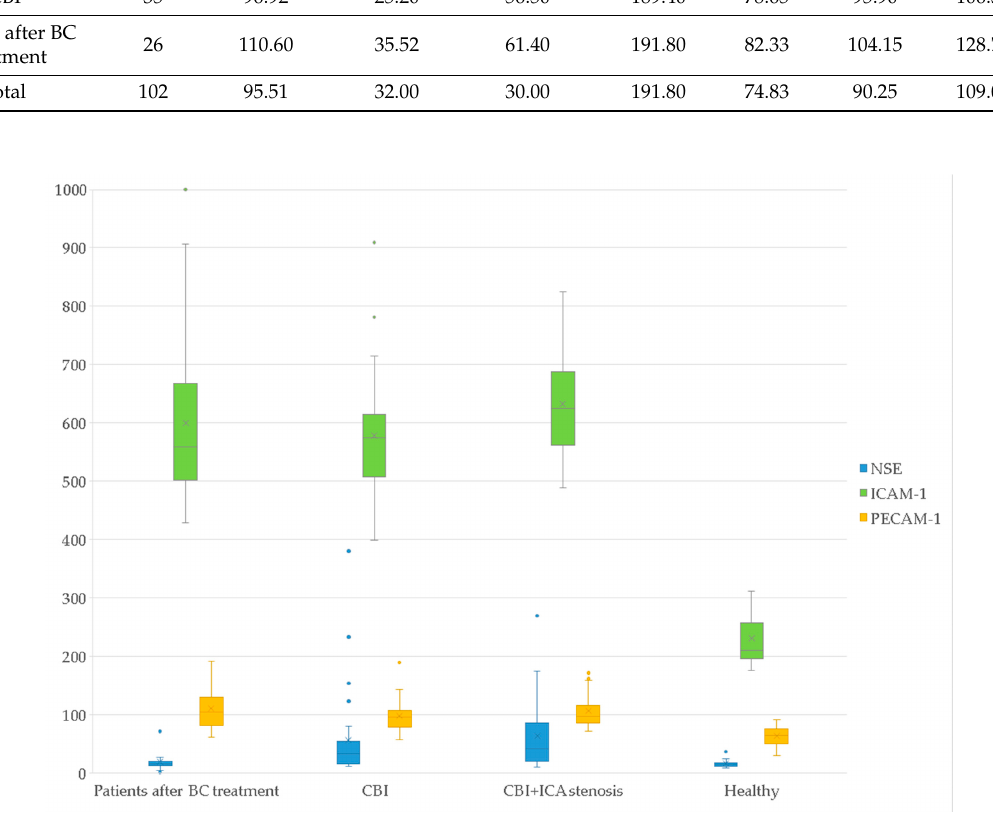
Figure 1. Serum levels of NSE, ICAM-1, and PECAM-1 molecules in the study groups (ng/mL).